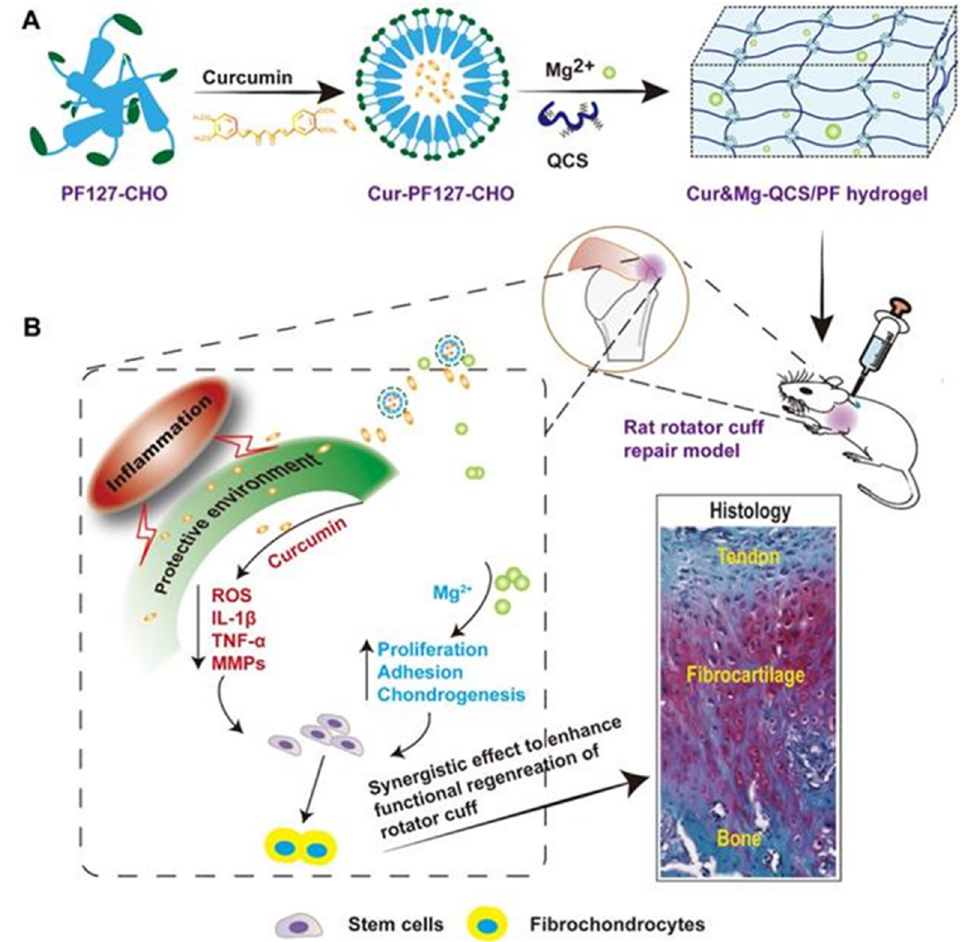
Figure 16. Schematic representation of ( A) Cur&Mg-QCS/PF hydrogel preparation, ( B ) functional mechanism of Cur&Mg-QCS/PF hydrogel for the repair of rotator cuff injury. (Reproduced with permission from Ref. [213] under Creative Commons Attribution License (CC BY)).